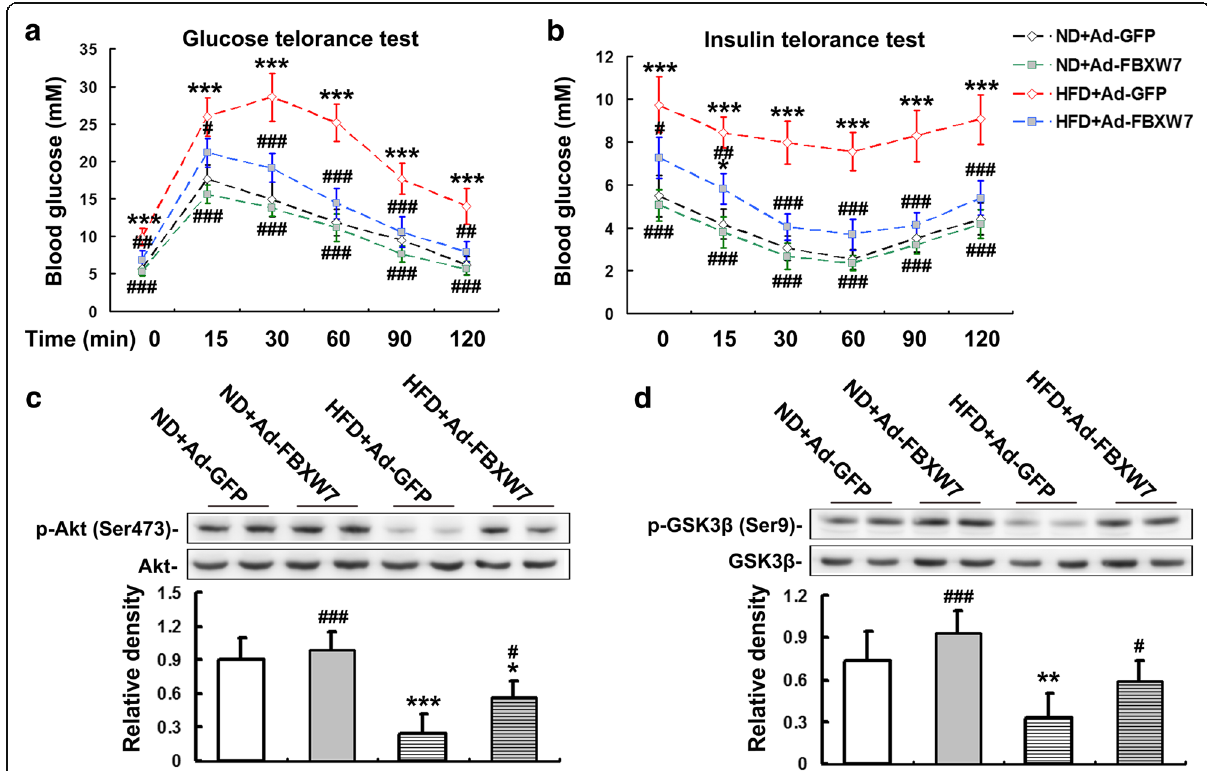
Fig. 2 FBXW7 alleviates insulin resistance in HFD-fed mouse livers ( n = 4). a Data of glucose tolerance tests in different treatment groups. b Data of insulin tolerance tests in different treatment groups. c Immunoblotting and densitometry of p-Akt in mouse livers. d Immunoblotting and densitometry of p-GSK3 β in mouse livers. All of the values are expressed as the mean ± SD. * P < 0.05, ** P < 0.01, *** P < 0.001 versus the ND + Ad- GFP group; # P < 0.05, ## P < 0.01, ### P < 0.001 versus the HFD + Ad-GFP